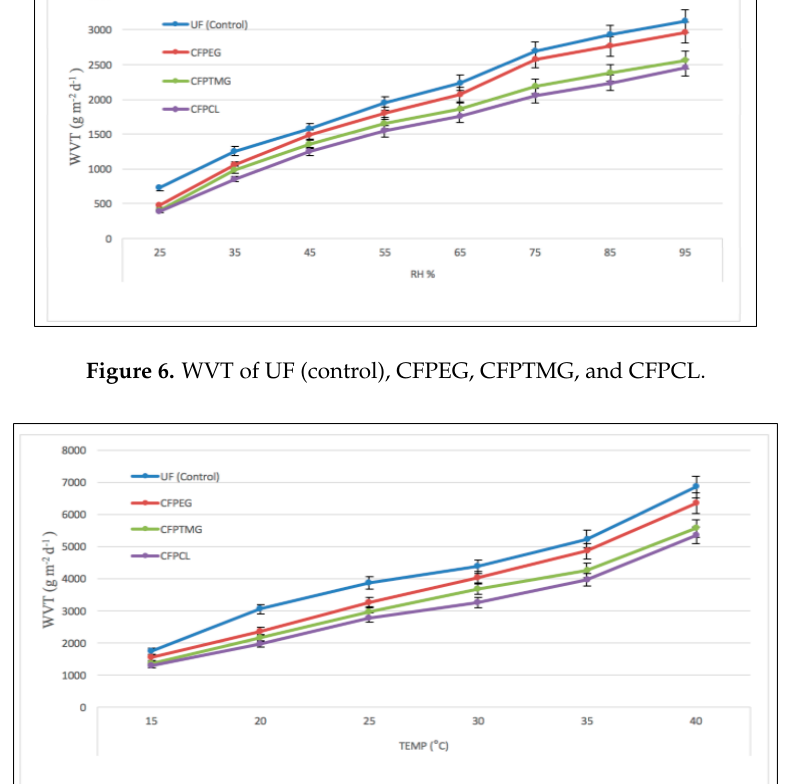
Figure 7. WVT of UF (control), CFPEG, CFPTMG, and CFPCL.